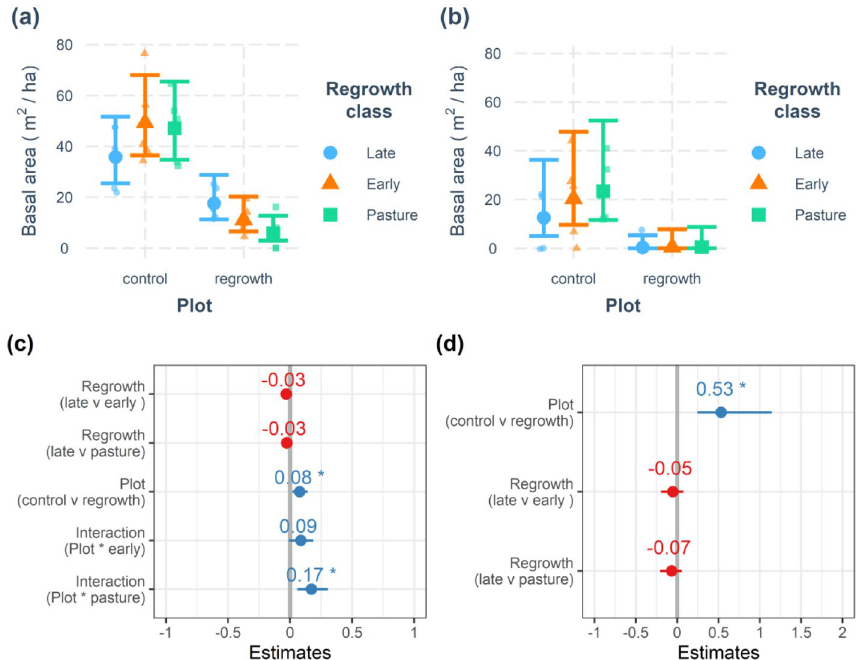
Figure 3. Basal area changes across a lowland forest regrowth gradient. The basal area of all ( a , c ) and large ( b , d ) living trees were recorded in 30 plots (15 control and 15 regrowth). Regrowth class shows differences between late second-regrowth, early second-regrowth and pasture plots contrasted with control forest plots. Top row shows Generalized Linear Model (GLM) predictions (mean and 95% confidence intervals) for basal area of ( a ) all and ( b ) large trees. Bottom row is the associated Forest-plot of the most parsimonious GLMs testing for interactions between regrowth class, plot type and years since last use in the basal area of ( c ) all and ( d ) large trees. Forest-plots show coefficient estimates and standard